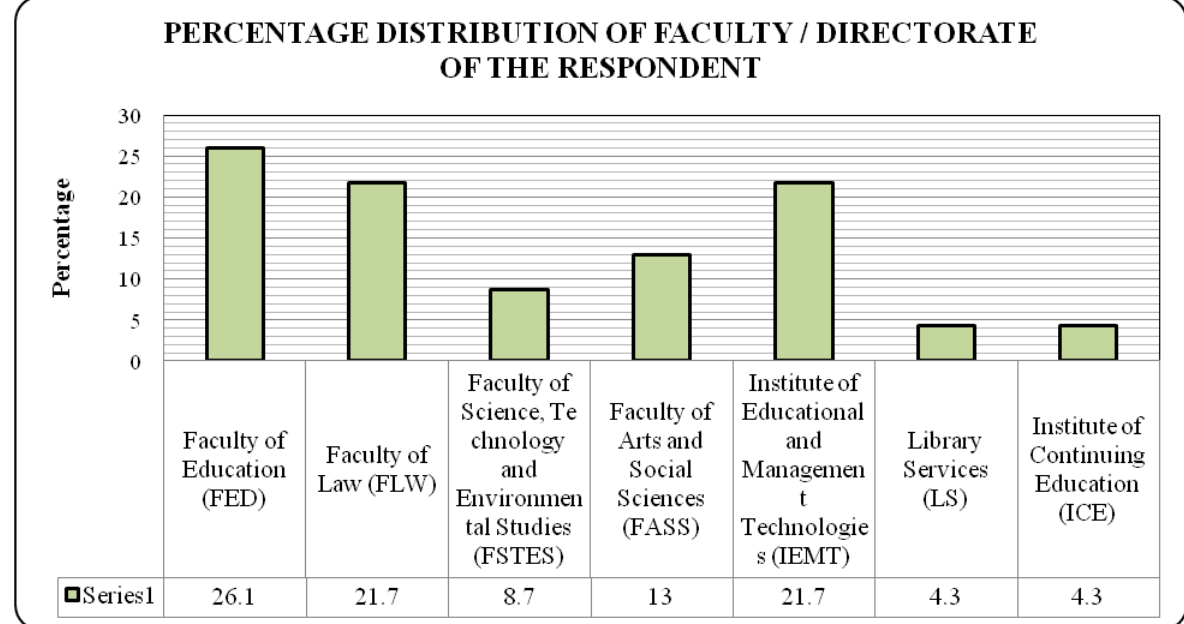
Figure 1 . Distribution of